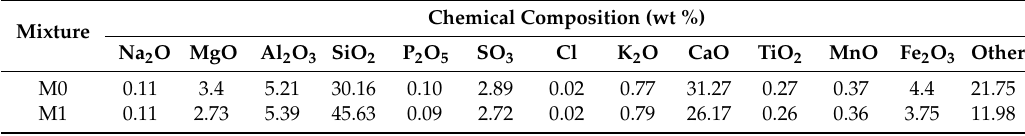
Table 1. Chemical analysis of the analyzed concrete